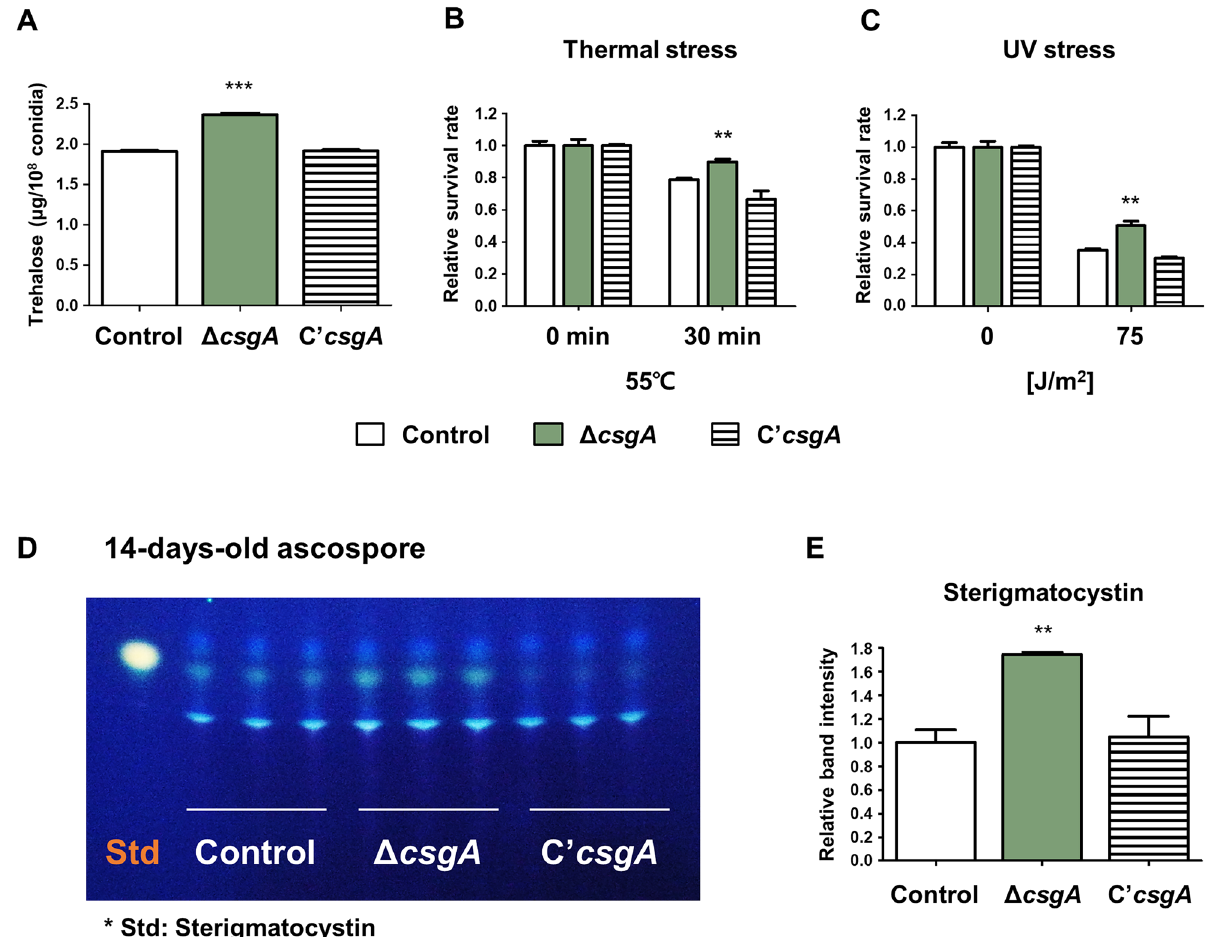
Figure 9. The roles of csgA in ascospores. ( A ) Trehalose levels in ascospores from control (TNJ36), Δ csgA (THJ13.1), and C’ csgA (THJ28.1) strains. ( B ) Thermal stress response of each strain following exposure to 55 °C. ( C ) UV stress response of each strain following exposure to UV light. ( D ) TLC plate showing the production of sterigmatocystin from 14-day-old ascospores from control (TNJ36), Δ csgA (THJ13.1), and C’ csgA (THJ28.1) strains. ( E ) Quantitative analyses of band intensities of each strain using ImageJ software. ** p < 0.01, *** p <